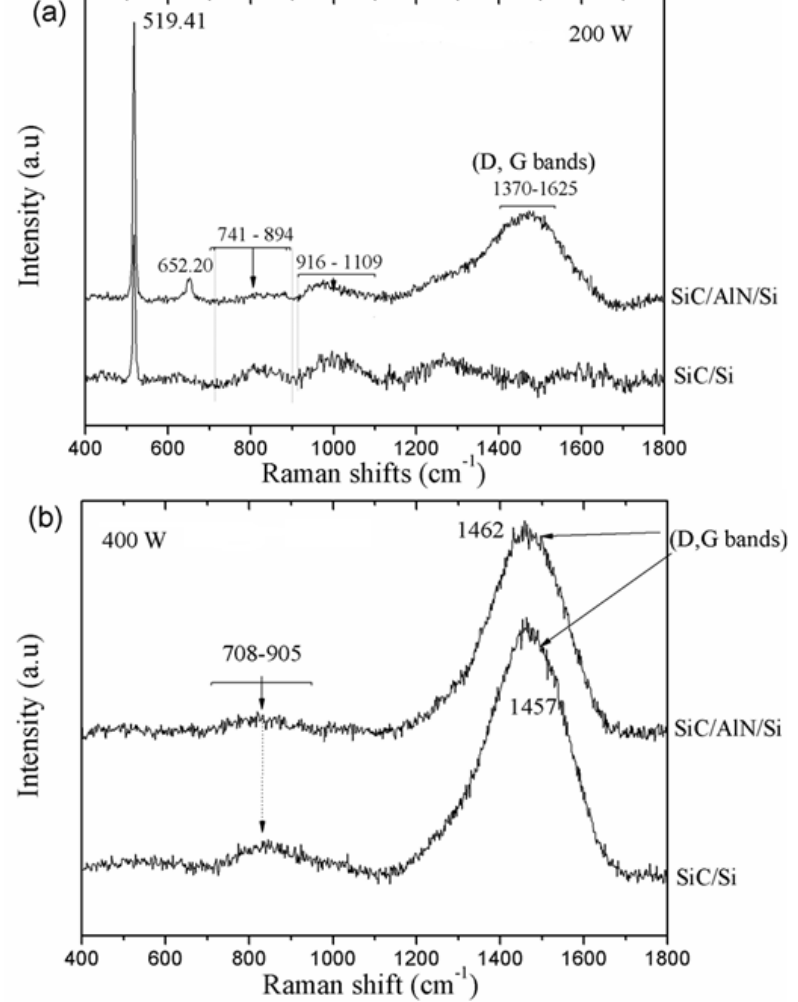
Figure 5. Raman spectra of SiC thin films on both substrates: ( a ) as-deposited at 200 W and ( b ) as-deposited at 400 W.